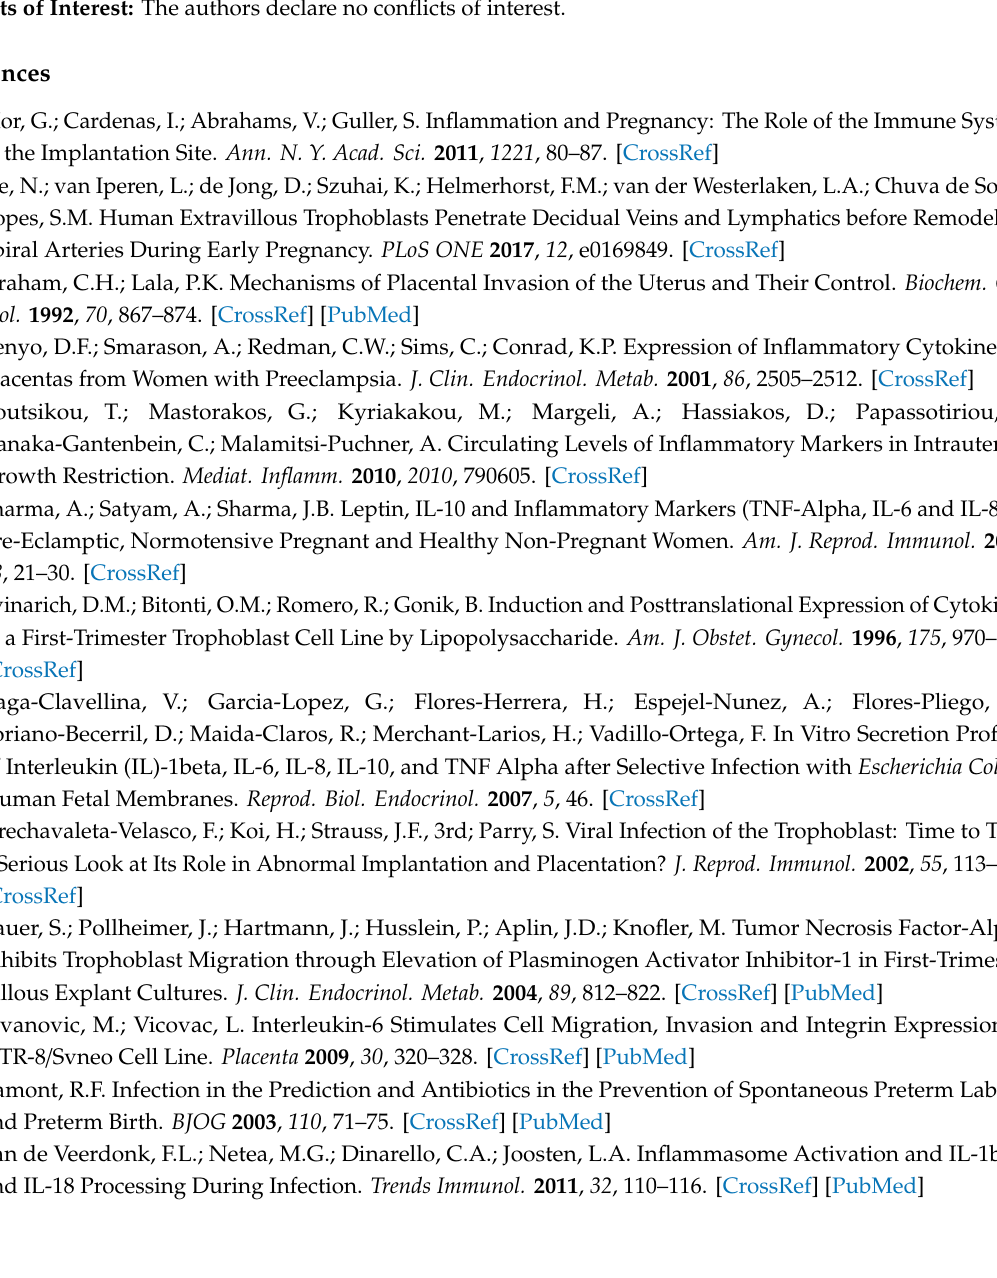
Figure S1: Expression of SIRT1 in HTR-8 / SVneo cells exposed to LPS; Figure S2: NLRP3 inflammasome activation in HTR-8 / SVneo cells exposed to LPS; Figure S3: SIRT1 inhibits LPS-induced NLRP3 inflammasome activation; Figure S4: SIRT1 overexpression suppresses LPS-induced oxidative stress in Sw.71